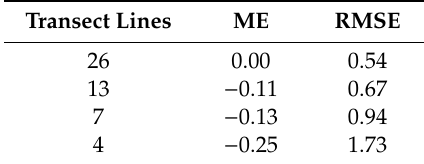
Table 4. Soil ECa map accuracy results, showing mean error (ME) and root mean square error (RMSE) from external